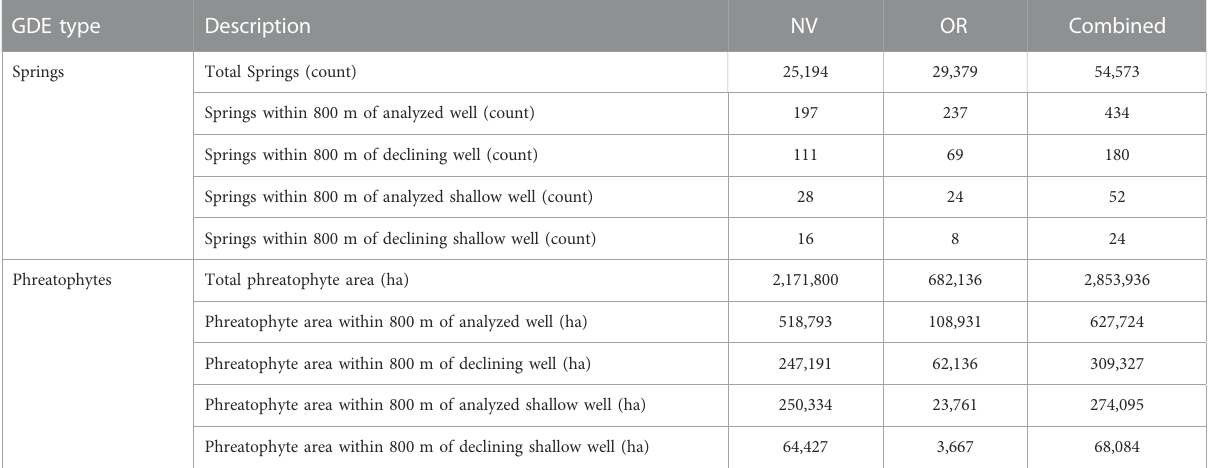
TABLE 1 Statistics for phreatophyte communities and springs in Nevada and